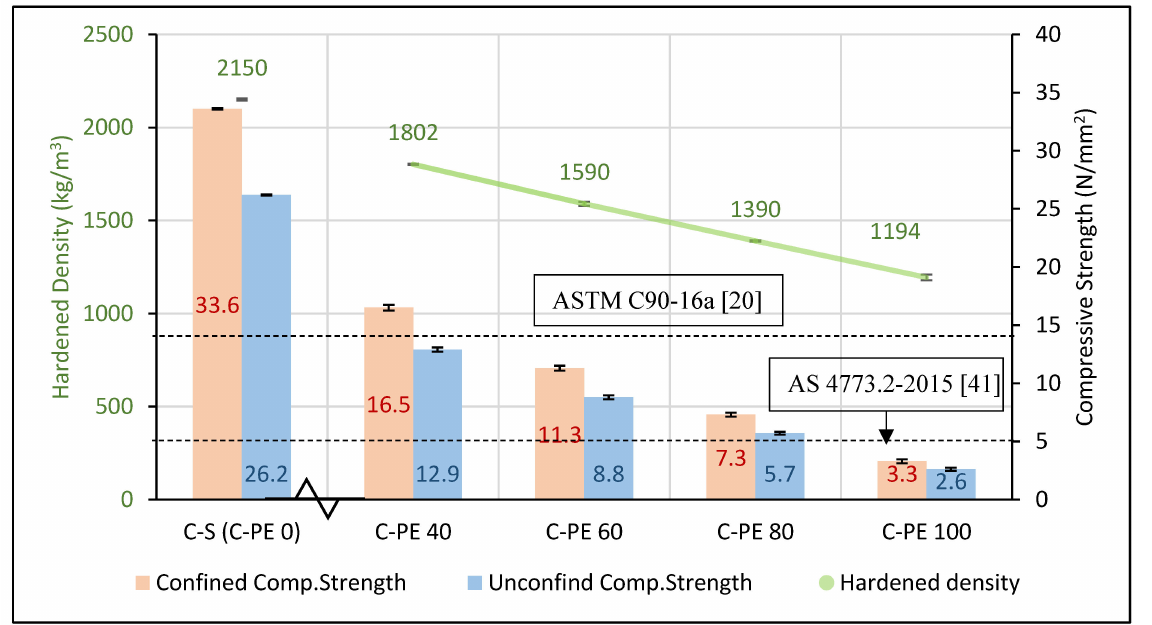
Figure 36. Hardened density and compressive strength of C-S and C-PE mixes with error